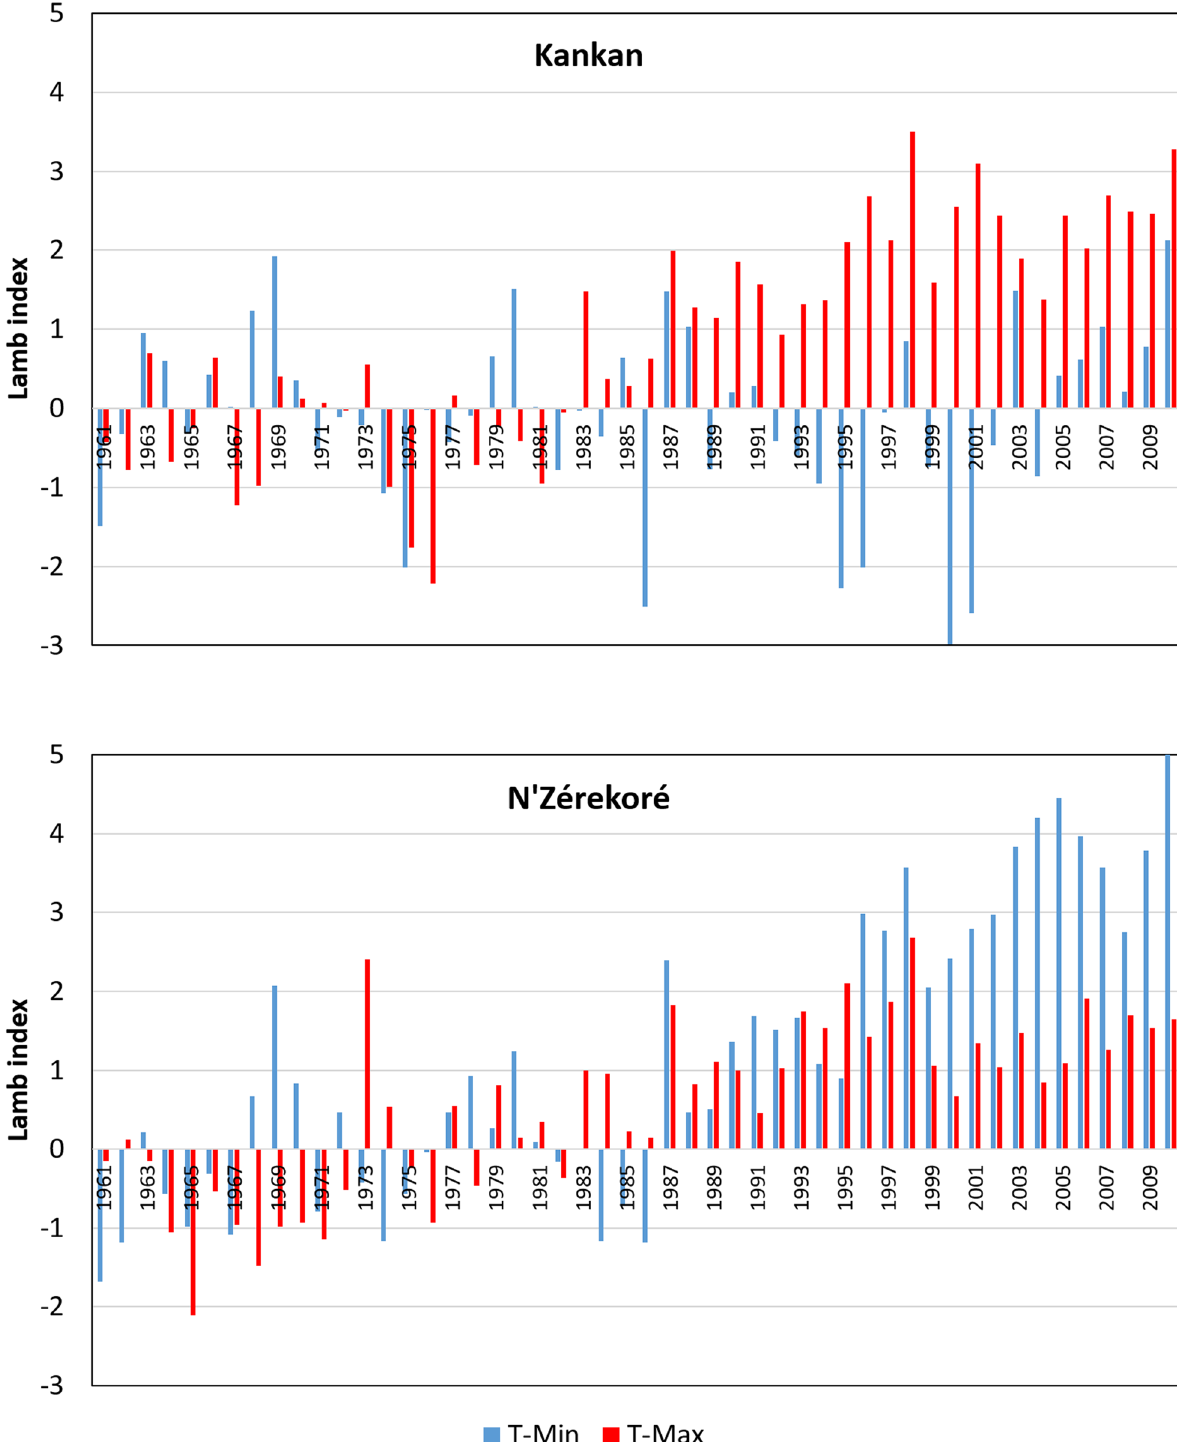
Fig. 2 Pattern of deviation of the annual average minimum (T-Min) and maximum (T-Max) temperature from the normal reference, during the 1961–2010 period, in Kankan (10°23 ′ 01.65 ″ N; 9°18 ′ 18.72 ″ W) and N’Zérekoré (7°’48 ′ 53.2 ″ N; 8°42 ′ 14.11 ″ W) sites of